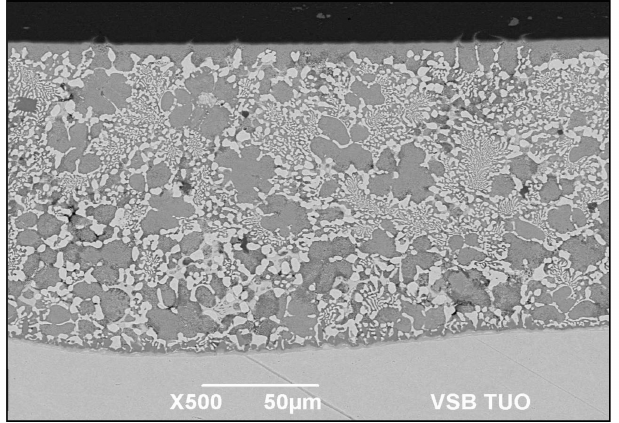
Figure 12. Microstructure of the boundary in Al7075/Zn5Al3Cu/Cu joint.